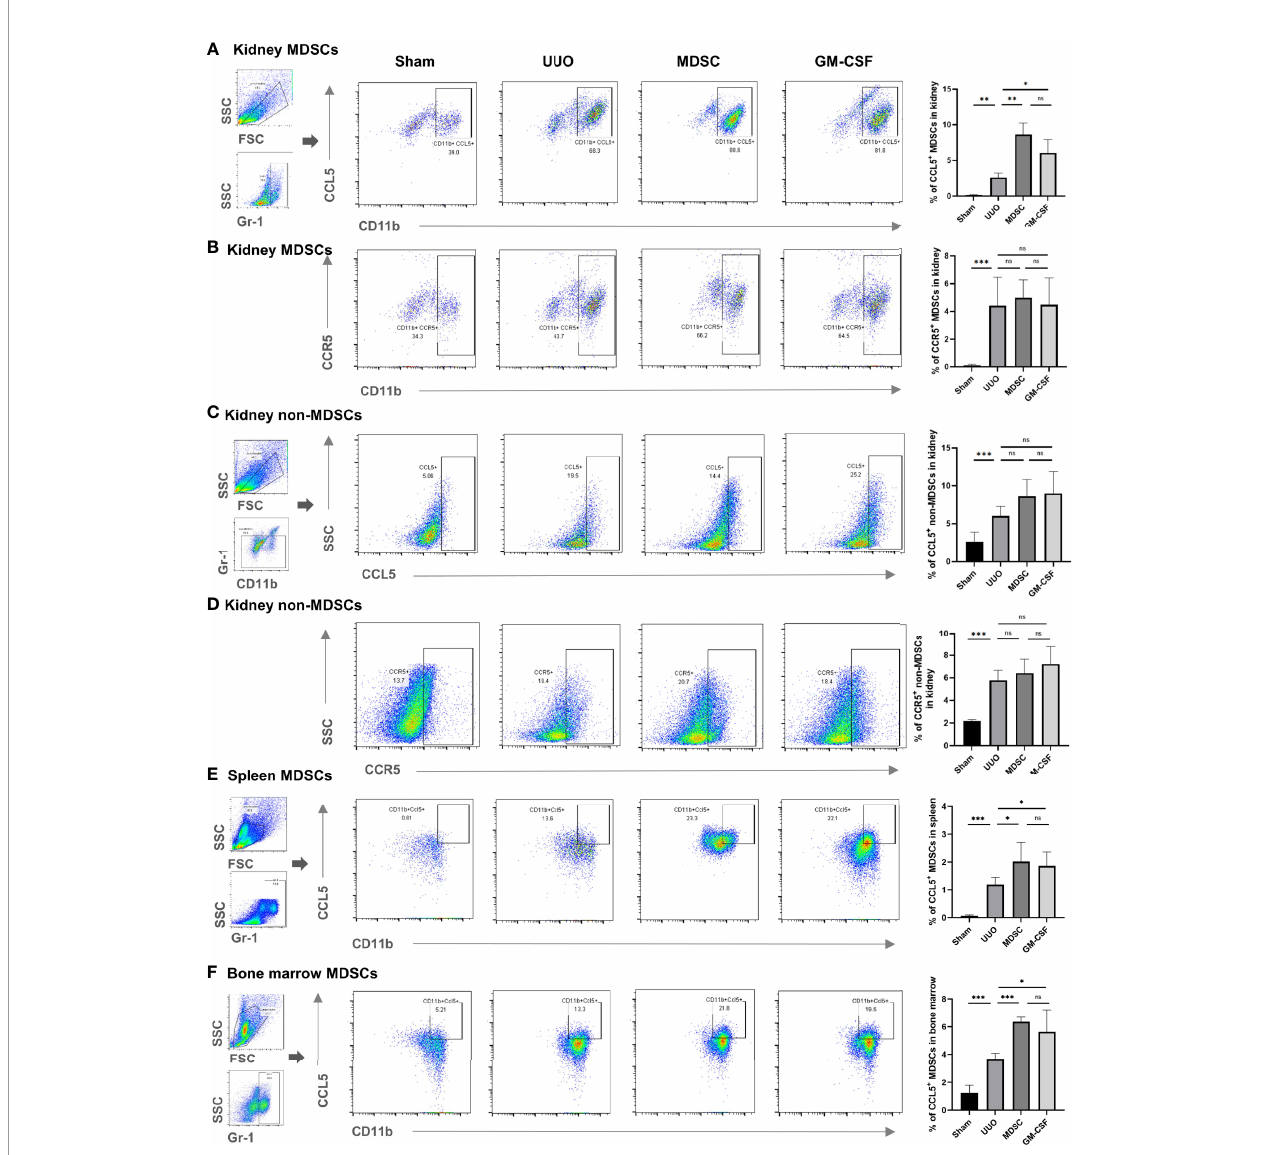
FIGURE 5 | Expression level of CCL5 and CCR5 in MDSCs and non-MDSCs in mice. Flow cytometry detected the percentage of (A) CCL5 + MDSCs in kidneys, (B) CCR5 + MDSCs in kidney, (C) CCL5 + non-MDSCs in kidney, (D) CCR5 + non-MDSCs in kidney, (E) CCL5 + MDSCs in spleen, and (F) CCL5 + MDSCs in bone marrow. Data are expressed as the mean ± SD (n = 6). * p < 0.05, ** p < 0.01, *** p < 0.001. ns^P >